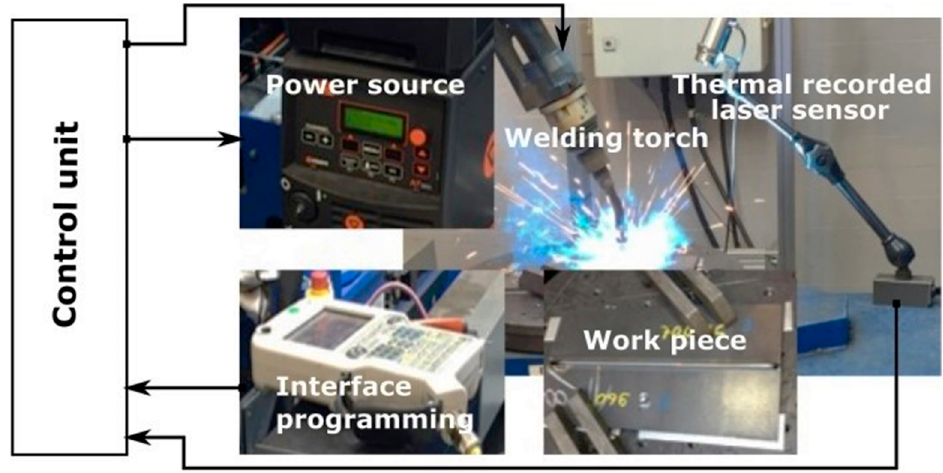
Figure 1. Automatic robot gas metal arc (GMA) welding process using a recorded laser thermal profile, ABB IRC 5 robot control unit.